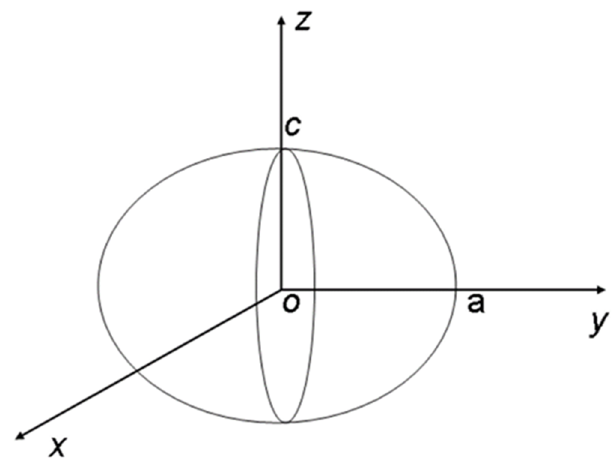
Figure 8. Spheroid with aspect ratio oa/oc.